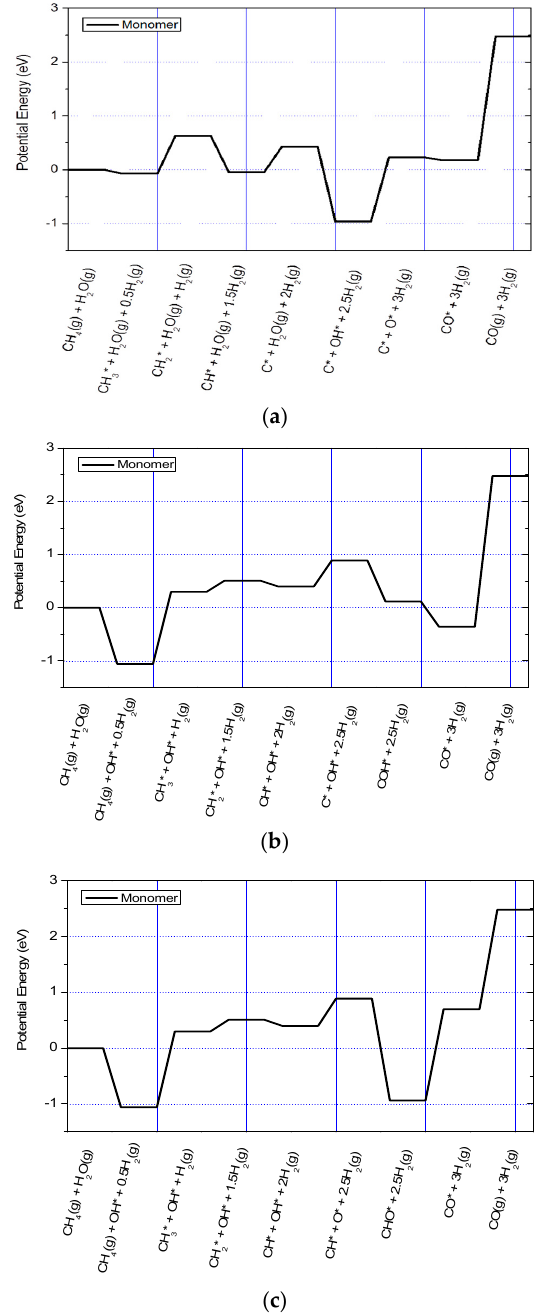
Figure 8. The 0 K potential energy profile of the CO*( a ), COH*( b ), and CHO*( c ) routes for the burn-off of monomeric carbon modelled on the Ni(322) step surface.